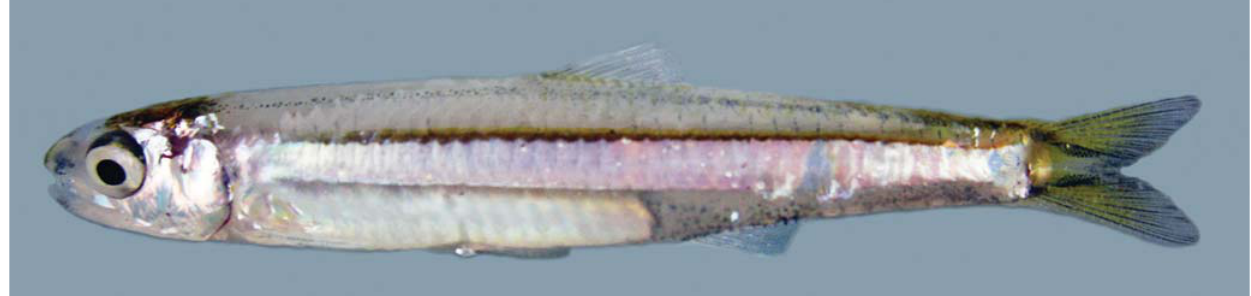
Fig. 2. Anchoviella juruasanga , freshly preserved specimen, MZUSP 103314, 46.0 mm SL, rio Jari, Monte Dourado, Pará State. Photo by J. L. Birindelli